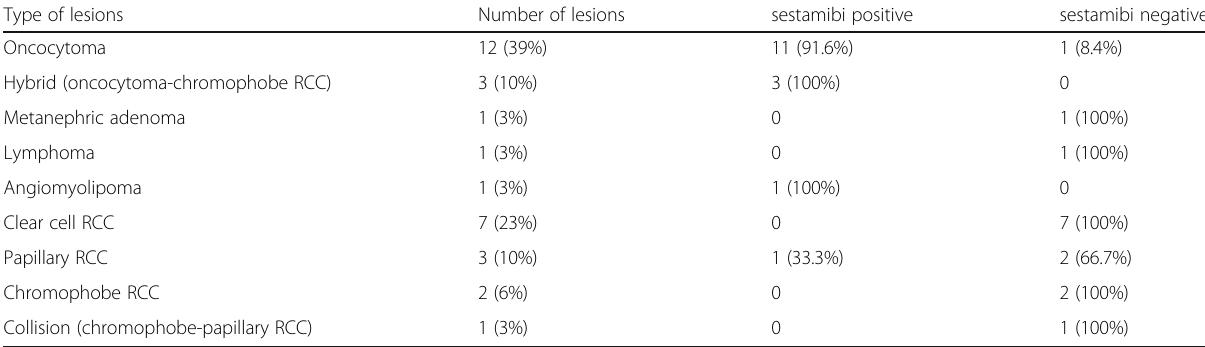
Table 2 Characteristics of 31 solid renal lesions in terms of sestamibi uptake Type of